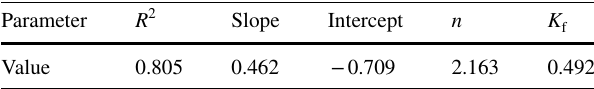
Table 3 Constants of Langmuir isotherm for the adsorption of CR dye by Aspergillus niger